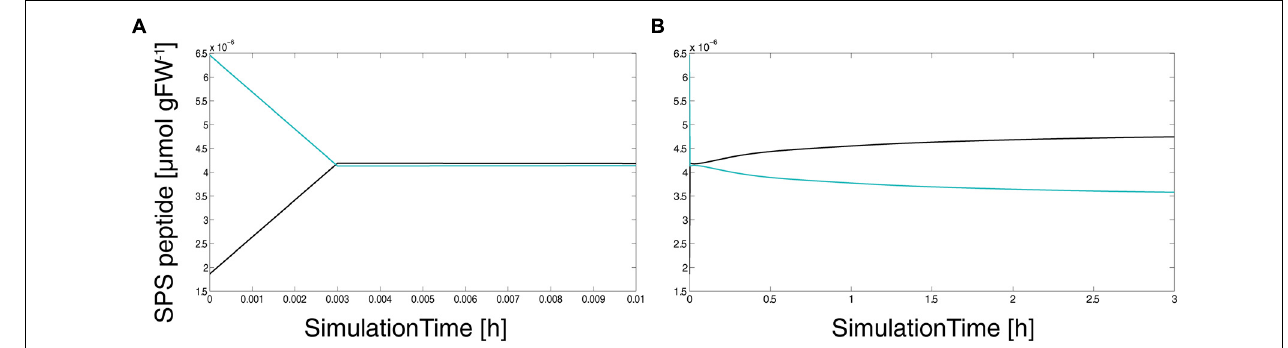
FIGURE 4 | Simulated time course of activated and inactivated SPS peptide. Black lines indicate activated/dephosphorylated SPS peptide, turquoise lines indicate inactivated/phosphorylated peptide. (A) shows the first 0.01 h after simulated external sucrose supply, (B) shows the whole simulation period of 3 h.